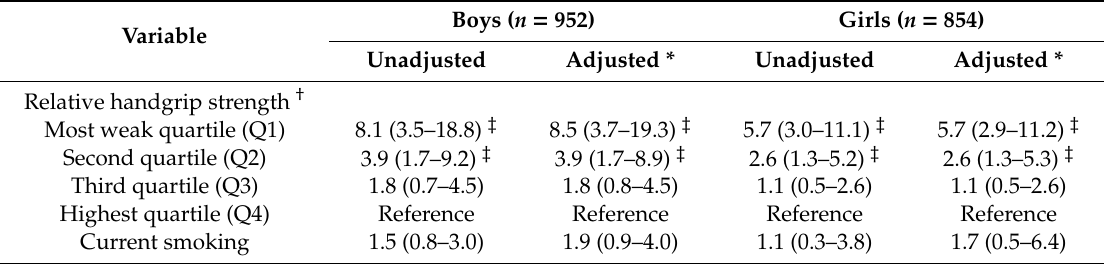
Table 2. Odds ratios for the association of relative handgrip strength and smoking behavior with high cardiometabolic risk.